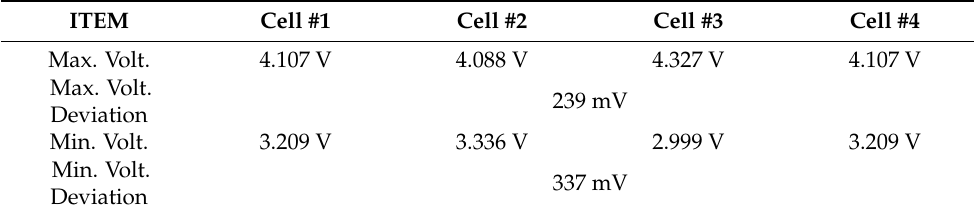
Table 1. Simulation results of charging and discharging of series-connected batteries. ITEM Cell #1